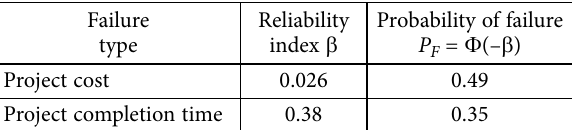
Table 1. Reliability indices and probabilities of schedule and cost overrun for 40 case-study projects